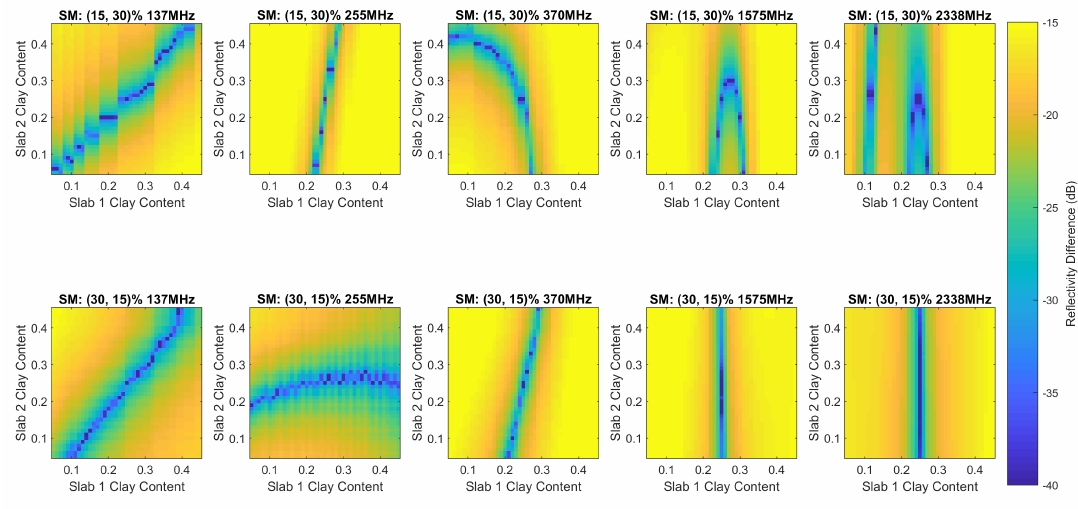
Figure 8. Relative difference between reflectivity measurements as a function of clay content within two soil slabs for different frequencies. The upper slab is 15 cm in height, and the second slab is semi-infinite. The top row of subplots show a configuration for SM values of 15% and 30% for Slabs 1 and 2, and the bottom row uses SM configurations of 30% and 15% for Slabs 1 and